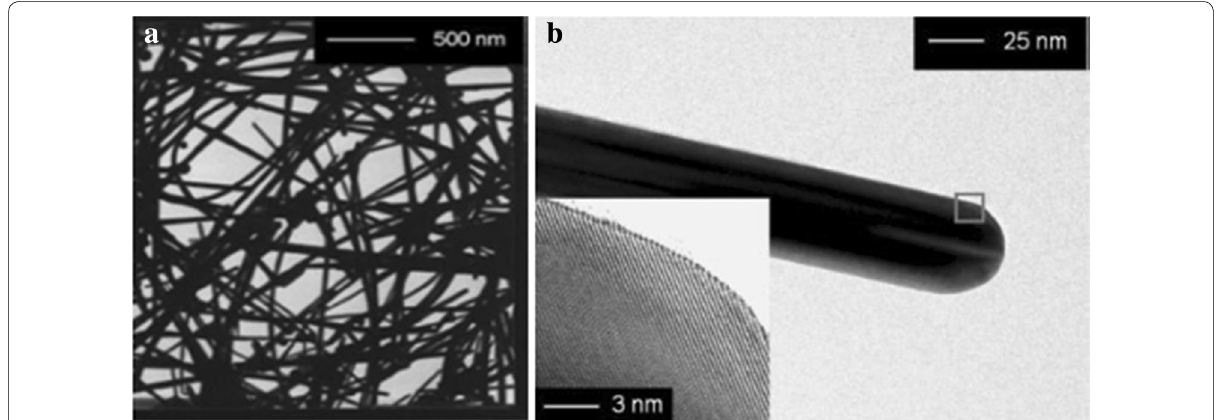
Fig. 7 a TEM images of gold nanowires, b inset shows high resolution image of gold nanowires [55]